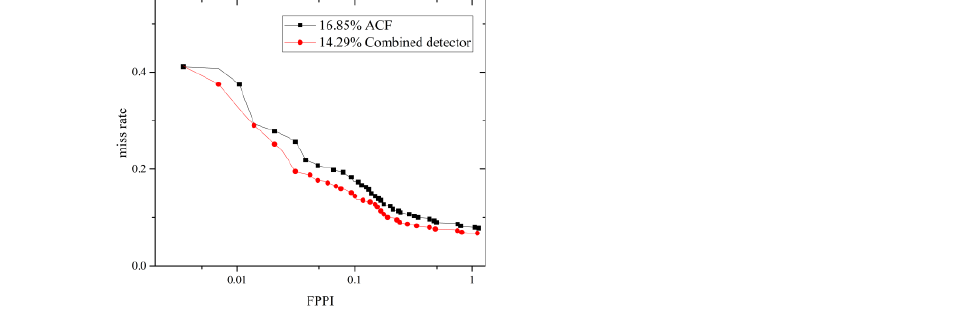
Figure 20. Miss rate versus FPPI for the ACF detector and the proposed integrated detector on the INRIA pedestrian test set. Table 7. Comparison of the detection results of the ACF detector and the integrated detector for the INRIA pedestrian test dataset.